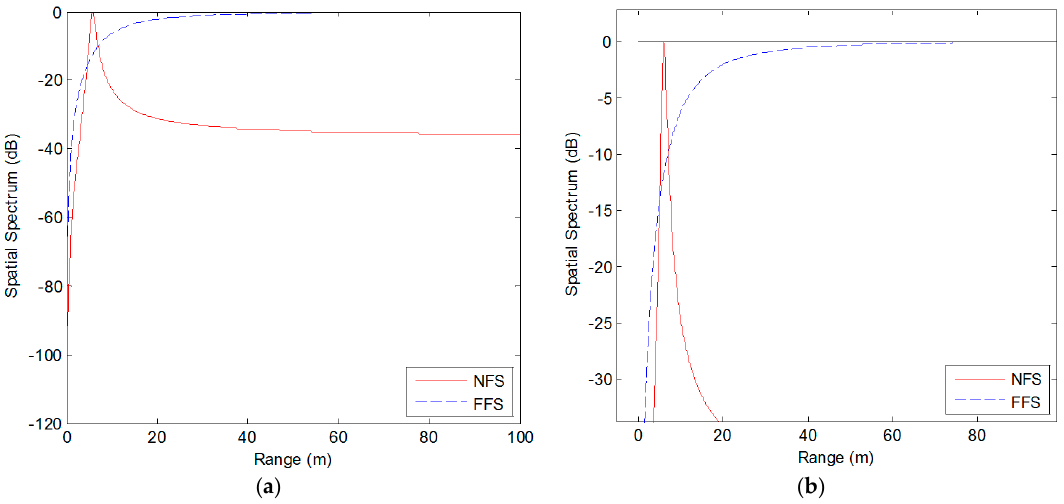
Figure 5. Spatial spectrum of range estimation: ( a ) Overall diagram; ( b ) Partial enlarged diagram.